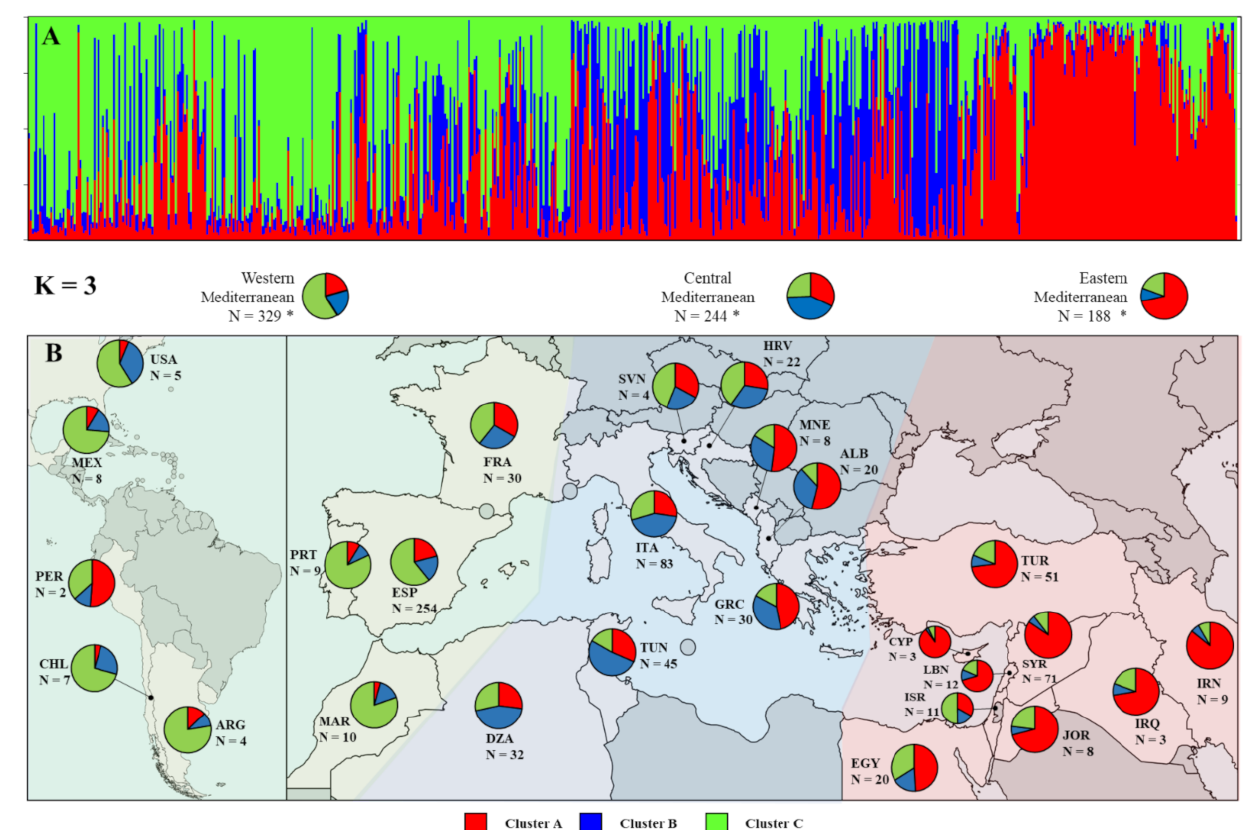
Figure 3. ( A ) Structure of olive genotypes from WOGBC characterized by means of EST-SNP markers following STRUCTURE analysis. Each cultivar is represented by a single vertical line divided into colours. Each colour represents one cluster, and the length of the coloured segment shows the individual’s estimated proportion of membership in that cluster. Clusters A, B, and C are associated with eastern, central, and western Mediterranean countries, respectively. ( B ) Distribution of different clusters from different countries in the Mediterranean Basin and beyond. * For each country, the total number of different cultivars was considered, regardless of synonymies between